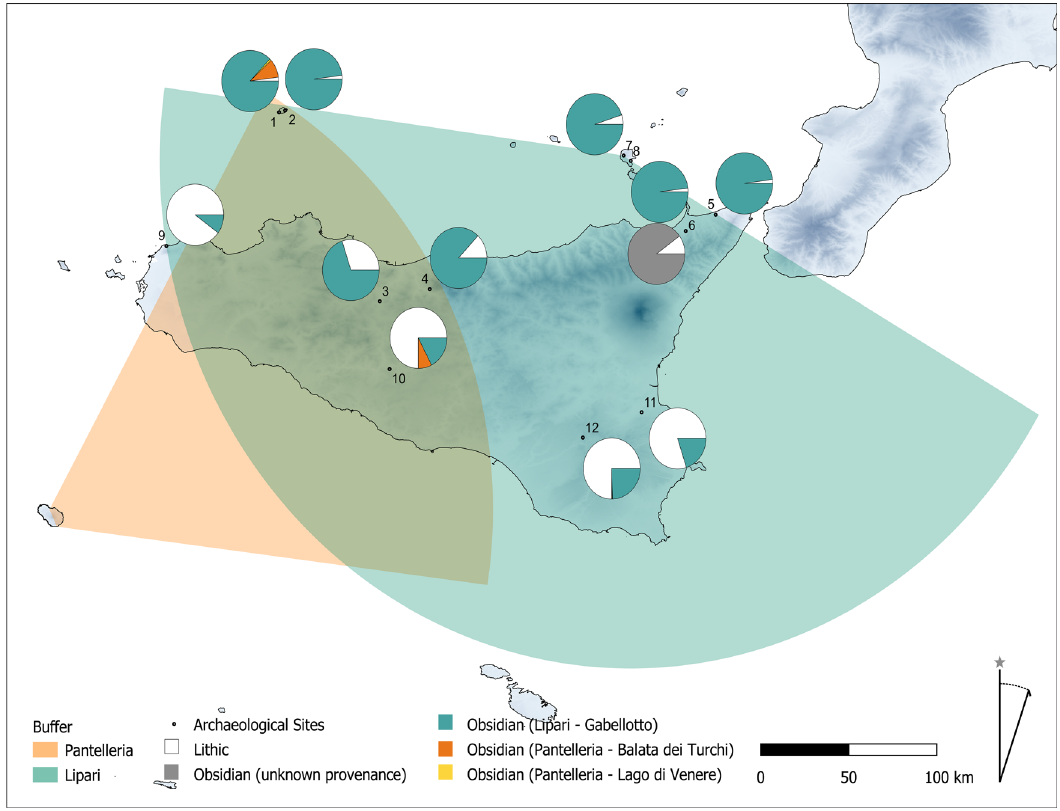
Figure 9: The fi gure is related to Table 3. 1 – Piano dei Cardoni, Ustica; 2 – Spalmatore, Ustica; 3 – Roccapalumba; 4 – Vallone Inferno, Scillato; 5 – San Martino, Spadafora; 6 – Contrada Limina, Barcellona P. G.; 7 – Castellaro, Lipari; 8 – Diana,